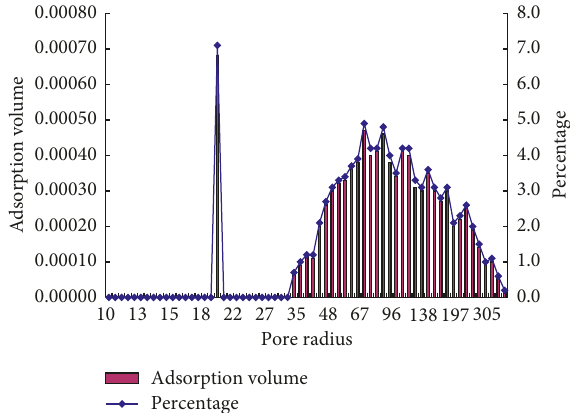
Figure 6: Line chart of pore radius and adsorption volume per- centage (with modifier